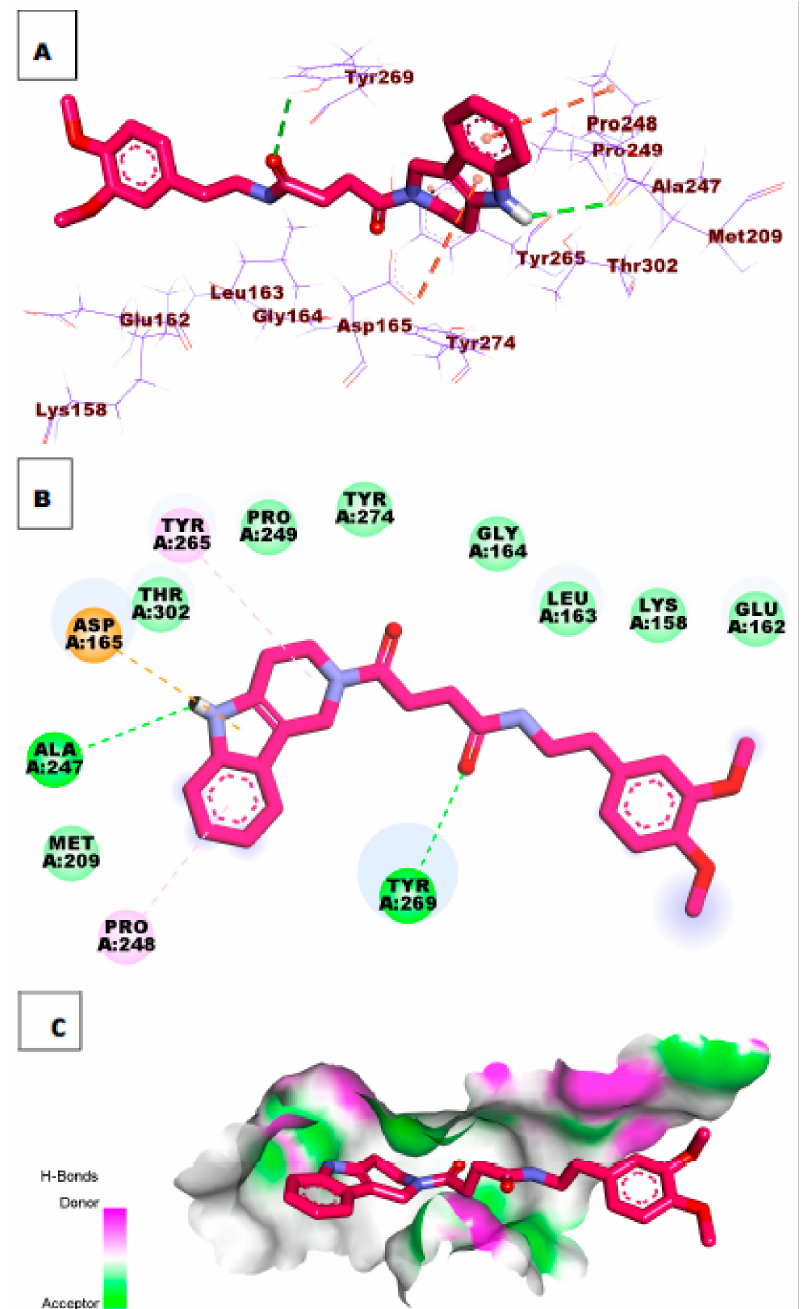
Figure 6. ( A ) 3D of compound 28 docked into the active site of PLpro. ( B ) 2D of compound 28 docked into the active site of PLpro. ( C ) Surface mapping of compound 28 docked into the active site of